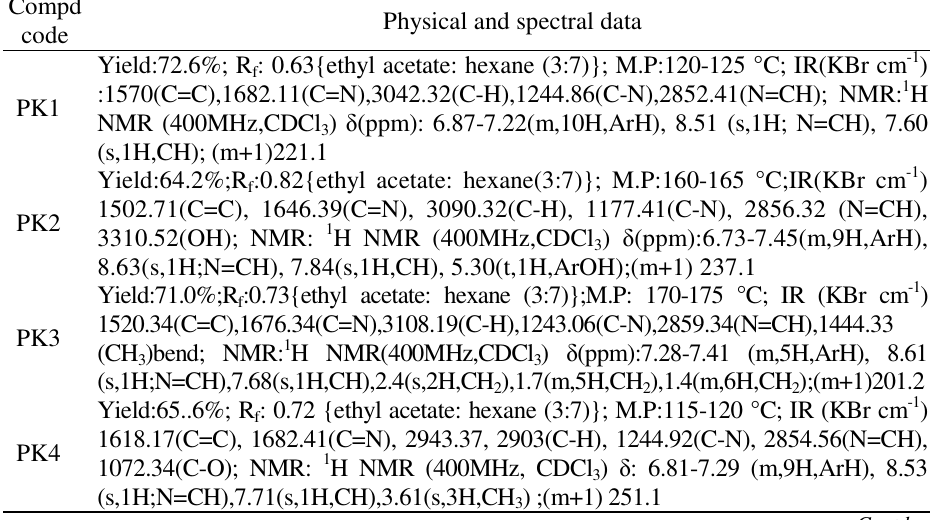
Table 2. Physical and spectroscopic data of synthesized